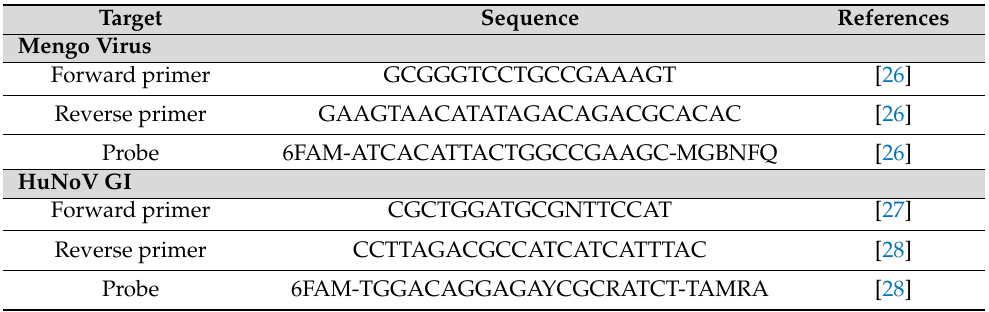
Table 1. Primers, probe sequences, quencher and dye used for detection of virus by RT-qPCR. Target